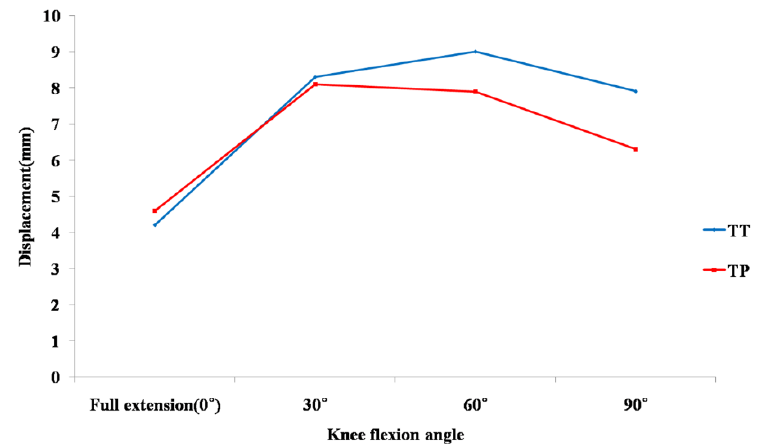
Figure 4. Comparison of anterior tibial translation under a 134 N anterior load between conventional single-bundle and anatomical double-bundle anterior cruciate ligament reconstruction. Abbreviations: TT, transtibial; TP, transportal.